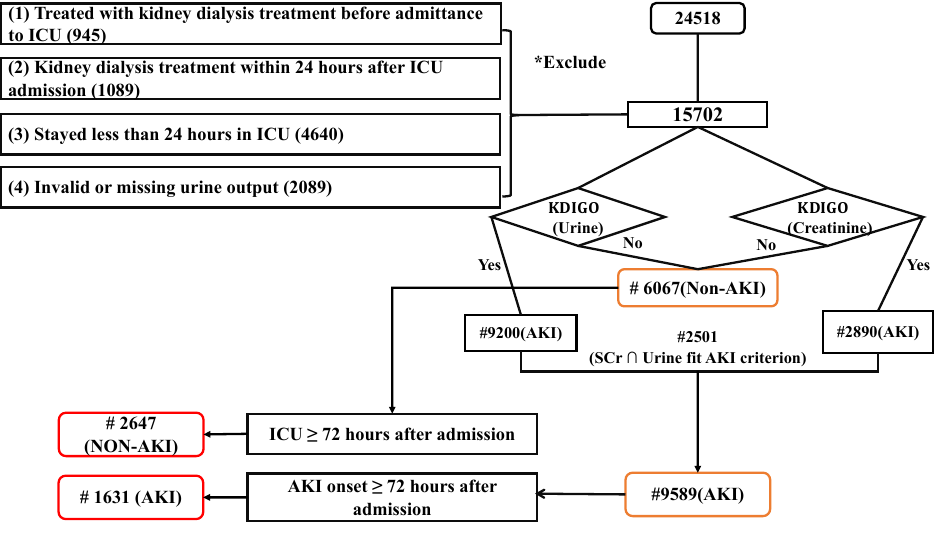
Figure 1. Data cohort